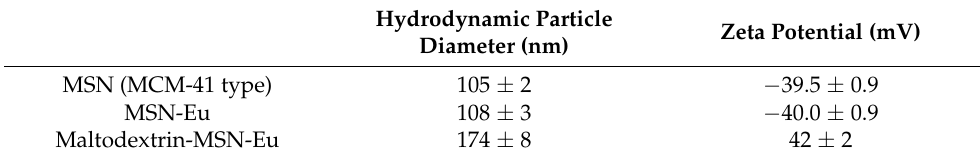
Table 3. Hydrodynamic diameter of materials measured by DLS and zeta potential